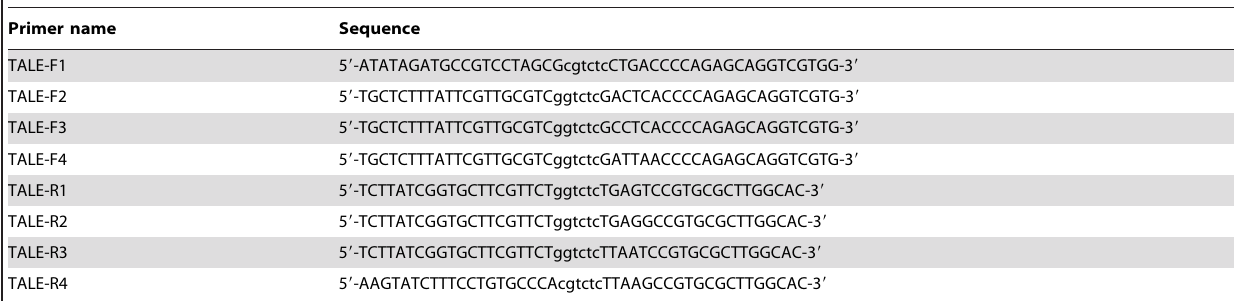
Table 1. Primer sequences for monomer amplification.